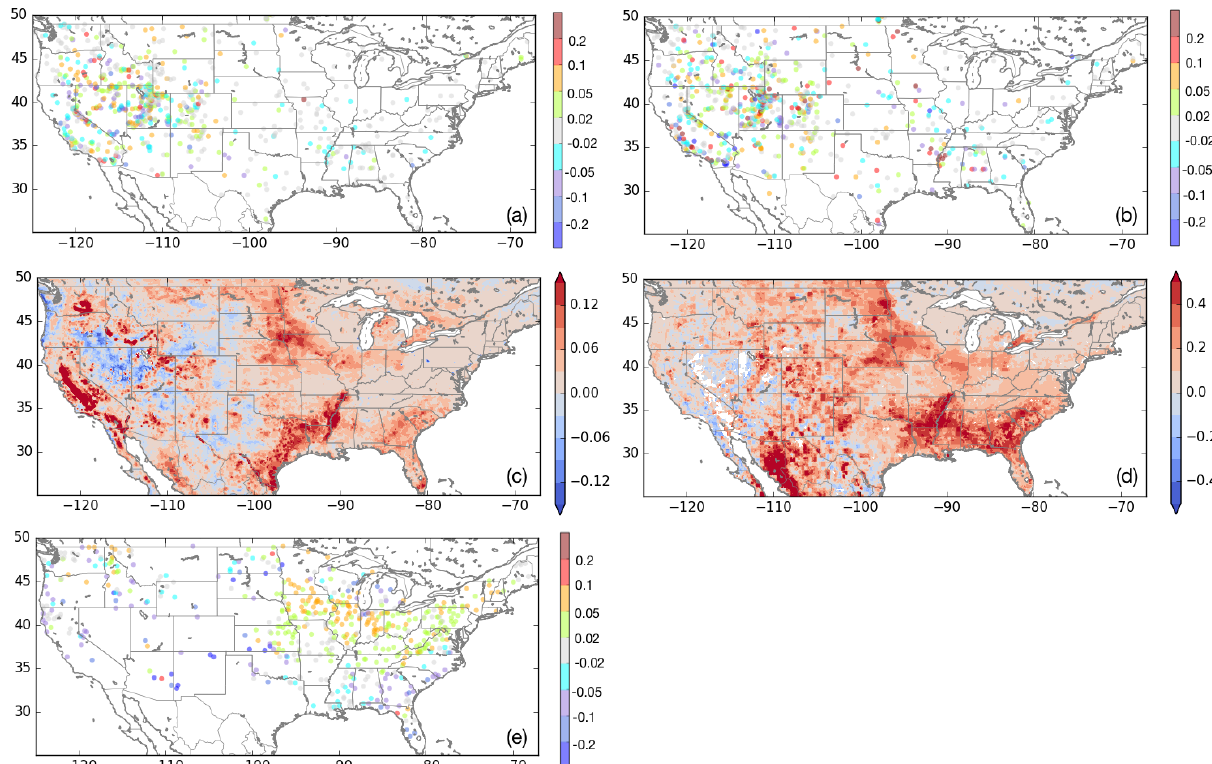
Figure 12. Impact of jointly assimilating SMAP surface soil moisture and VOD retrievals on surface soil moisture (a) , root zone soil moisture (b) , ET (c) , GPP (d) , and streamflow (e) . Panels (a) and (b) show differences in anomaly R values using ISMN data as the reference; panel (c) shows the differences in R values for ET using ALEXI as the reference dataset; panel (d) shows the difference in R values for GPP with GOME-2 SIF retrievals as the reference; panel (e) shows the NIC in streamflow using USGS daily streamflow observations as the reference. In each panel, the differences in the metric of evaluation are computed relative to the